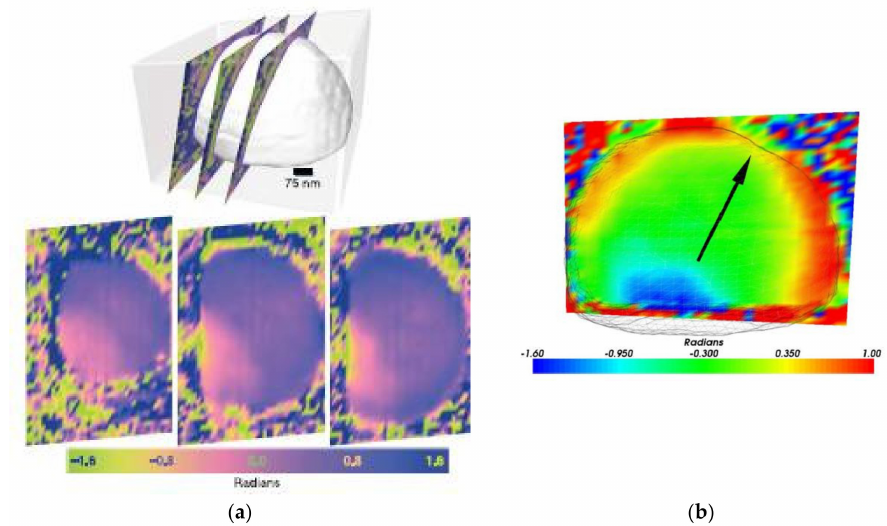
Figure 4. ( a ) Phase mapping inside a lead particle for 3 parallel sections that are 138 nm apart. The phase variations come from the deformation field generated by the contact forces at the interface with the substrate. ( b ) Phase anisotropy approaching free surfaces; the arrow indicates the direction [111] of the scattering vector [19,75]. Reprinted from [19,75]. Reprinted figure with permission from [75]. Copyright (2007) by the American Physical